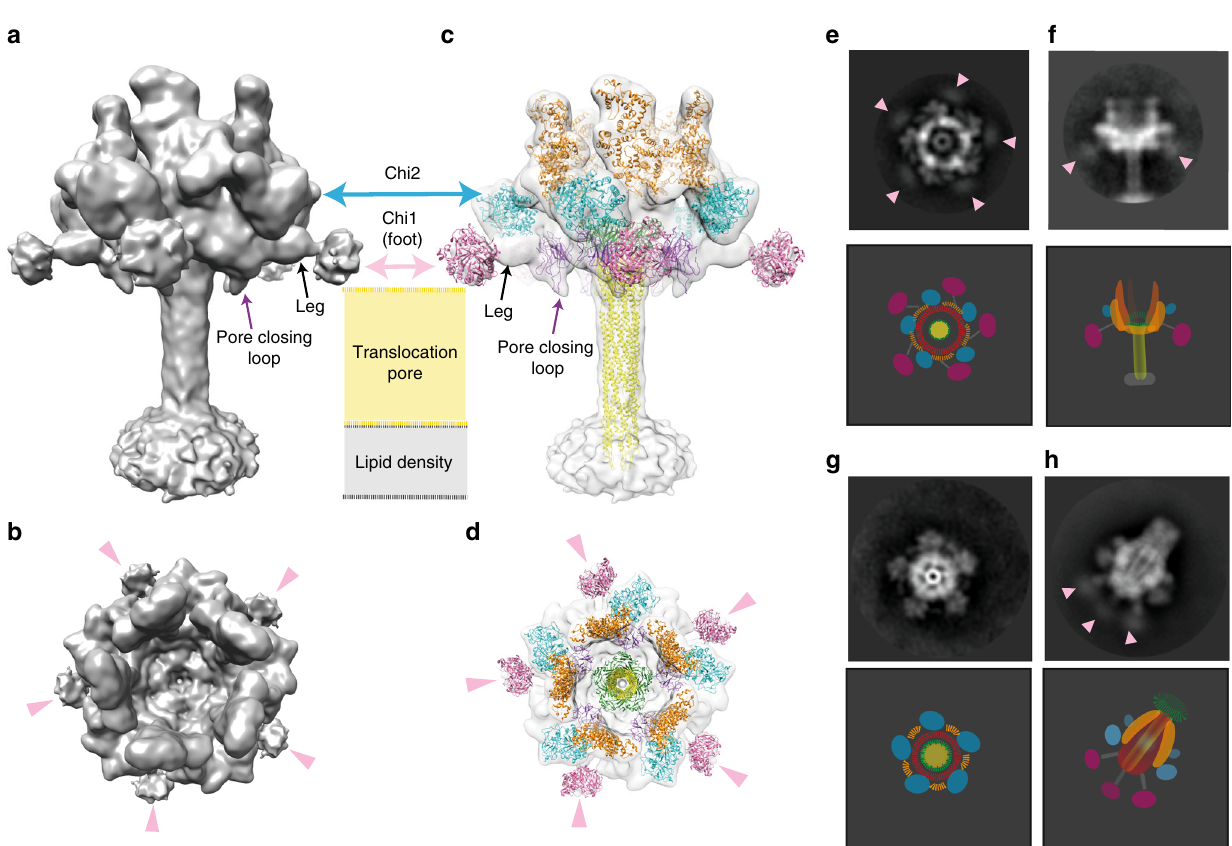
Fig. 4 Structural analysis of YenTcA inserted into liposomes. a , b 3D reconstruction of YenTcA incorporated into POPC liposomes at an estimated resolution of 11 Å. c , d Pseudo-atomic model of the YenTcA pore form using the same map shown in a , b : despite low resolution, domains of the YenTcA pre-pore atomic model (Fig. 1) could be rigidly fi tted into representative densities of the YenTcA pore form map: Chi1 (pink), Chi2 (cyan), pore (yellow), TcB-binding domain (green), neuraminidase-like domains with pore-closing loop (purple) and a substantial part of the A1 shell domain (A1 236 – 1161 , orange). The map, as well as comparative 2D class averages of the pore ( e , f ) and pre-pore forms ( g , h ) reveals clear structural rearrangements evident in the liposome-inserted map, most strikingly the protrusion of the translocation pore from the base of the complex and the outward rotation of the Chi1 subunits (pink arrowheads in b , d , e and f ). The class averages are representative top ( e ) and side views ( f ) of the pore form, and top ( g ) and side views ( h ) of the pre-pore form. Beneath each of the class averages is a schematic representation of the complex that indicates the location of different structural subdomains. Colouring mirrors the colour scheme throughout the manuscript: orange — YenA1 α -helical shell; red — YenA2 α -helical shell; green — TcB- binding domain; yellow — pore domain; cyan — Chi2; pink —